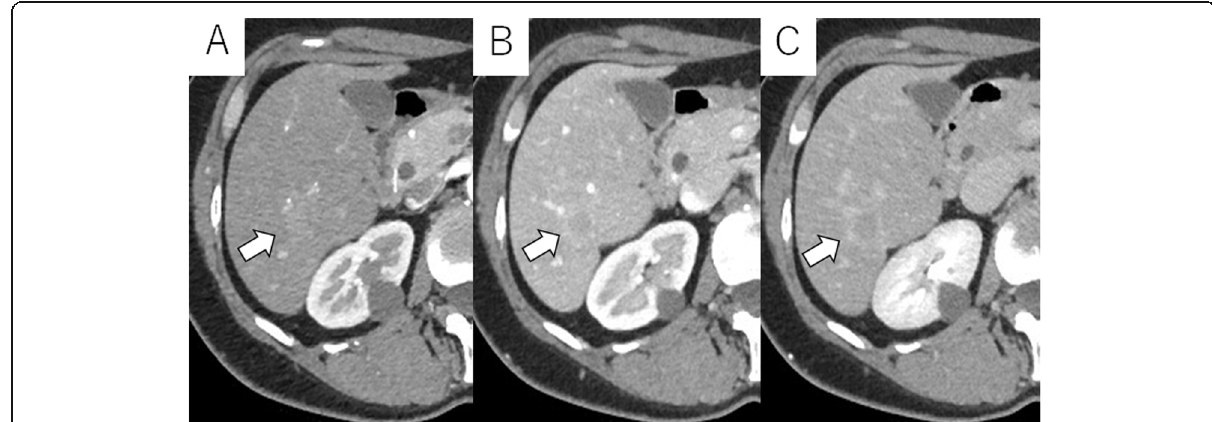
Fig. 2 On CT, the nodule is slightly enhanced in the arterial dominant phase ( a ). The lesion shows perinodular enhancement in the portal and delayed phases ( b , c ) (white arrow)